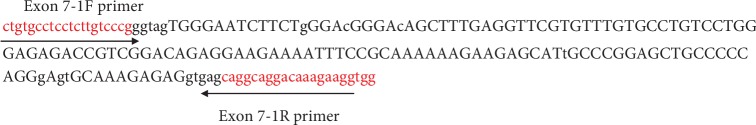
Nucleotide sequence of the amplified PCR product (188 bp) representing exon 7 of rat p53 gene in the control group.